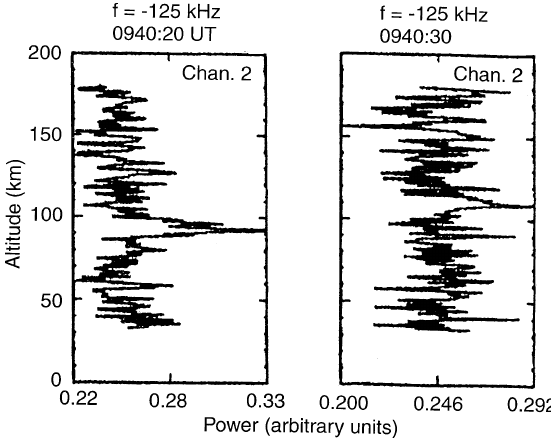
Fig. 5. Power profiles on 18 August 1989 for Az " 45 ° and El " 10 ° . The figure shows an example of downshifted echoes occurring in successive 10-s data intervals in the same receiver channel centred at f "! 125 kHz. The power is in arbitrary